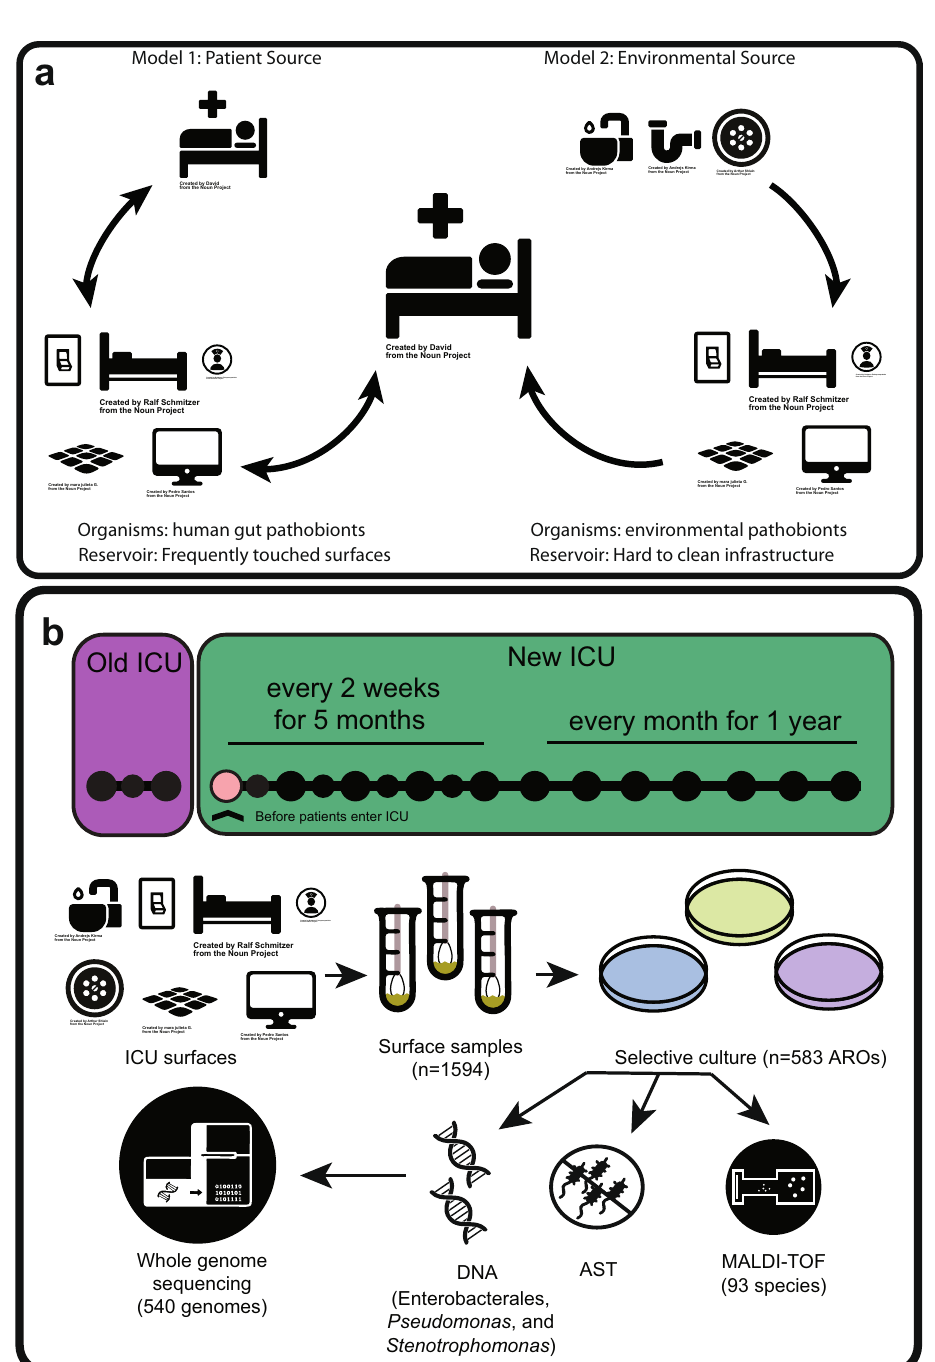
Fig. 1 ARO reservoir colonization models and sample processing scheme. a Two models of reservoir colonization. Model 1 shows antibiotic-resistant organism (ARO) transmission from patients to hospital surfaces and then to other patients. Model 2 shows ARO transmission from environmental reservoirs to hospital surfaces to patients. b Sample collection time points and sample processing scheme from surface collections to WGS. In sample collection scheme, large circles represent months with small circles representing 2-week sampling within months. Purple indicates old intensive care unit (ICU) collections, green indicates new ICU collections, and pink indicates collections taken before patients enter the building in the new ICU. Icons labeled as such were acquired from nounproject.com, and other icons were used with permission from D ’ Souza, Potter et al. 82 . AST antibiotic susceptibility testing, MALDI-TOF matrix-assisted laser desorption/ionization-time of fl ight mass